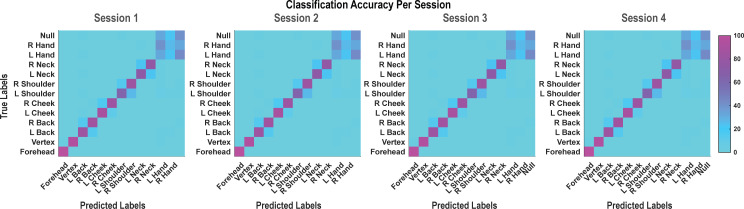
Population classification statistics were qualitatively unchanged between data recording sessions.Each panel from left to right represents the confusion matrix of a labeled recording session. The cross-validated classification accuracy (as percentage) in predicting actual touch conditions from population neural data is shown. These data are averaged in the matrix shown in Figure 1C. L: left; R, right.